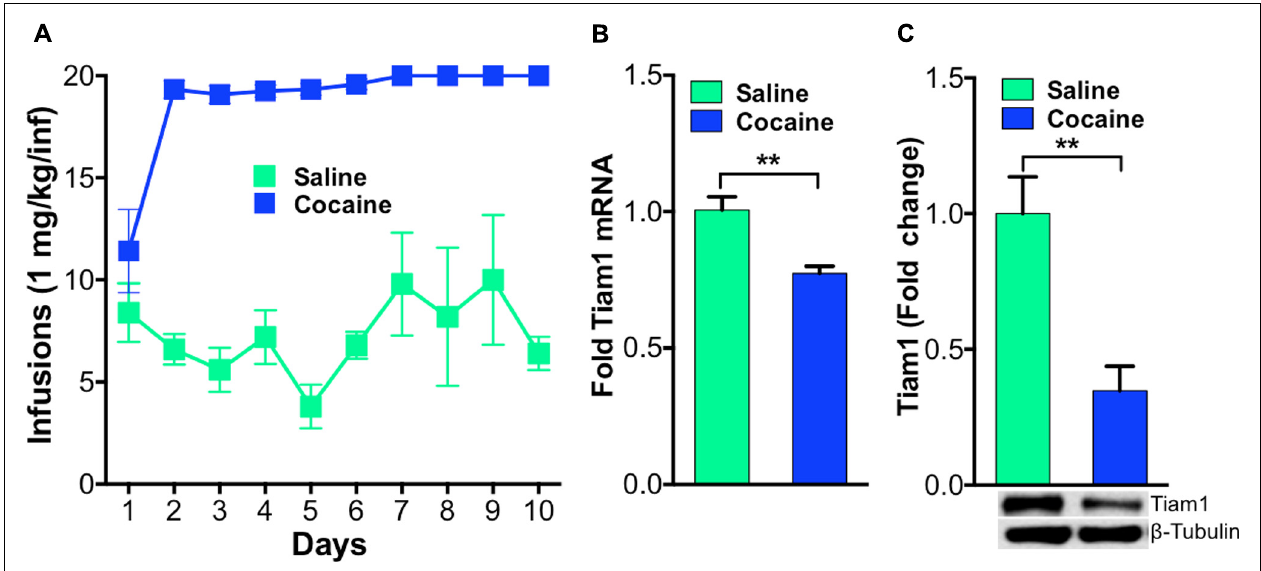
test, p < 0.05). (B) Following cocaine self-administration,Tiam1 mRNA is significantly decreased in the NAc compared to saline controls ( n = 6